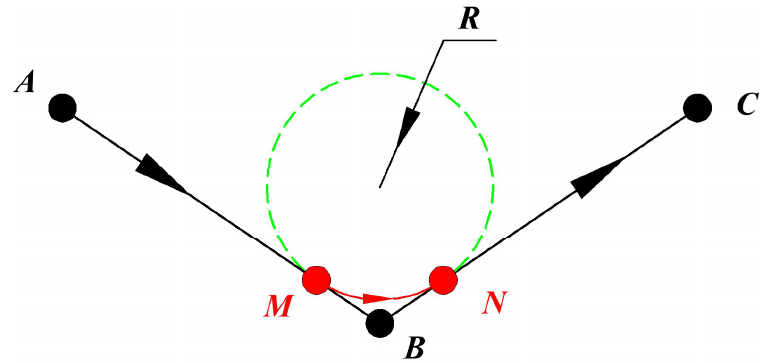
Figure 1. Schematic diagram of the spiral trajectory